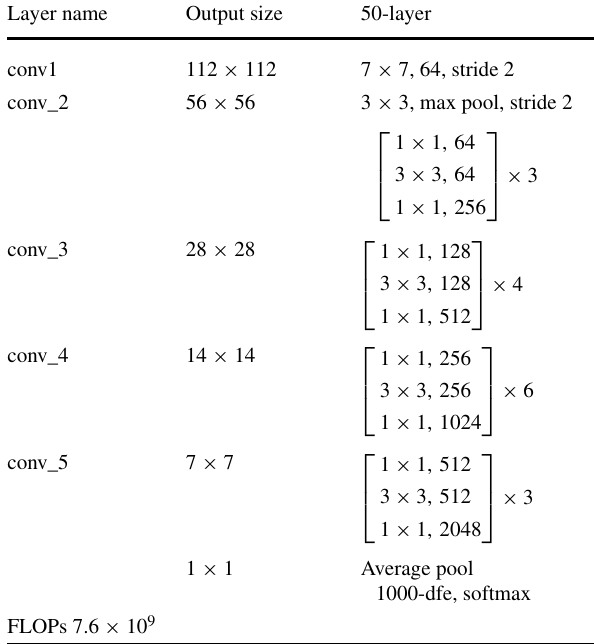
Table 1 Resnet50 network